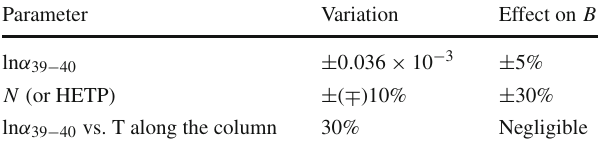
Table 3 Output parameters of the calculation of 39 Ar– 40 Ar distillation with the McCabe–Thiele method, for B / F = 50%. Input parameters are